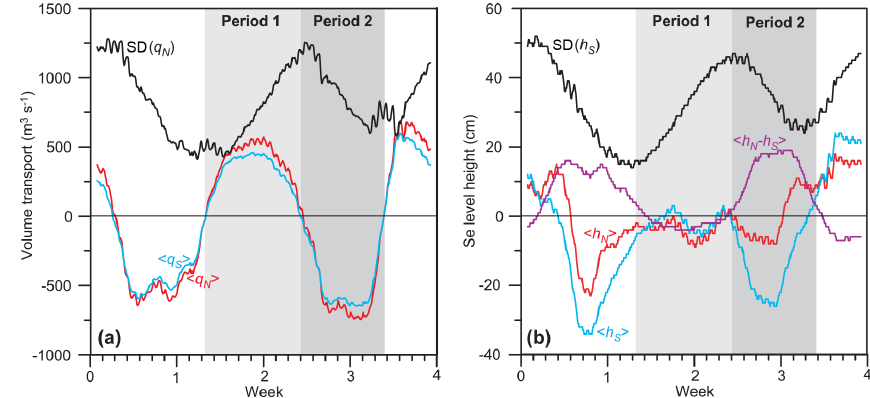
Figure 7. Daily (25h) averages ( <> ) and standard deviations (SD) within each 25h period for (a) volume transports and (b) sea level heights. The standard deviations ought to be dominated by the strength of the tidal amplitudes and should therefore reflect the variation between spring and neap tides. The shaded areas indicate two periods discussed in the text: Period 1 lasting 188h from 21 February at 08:00LT to 1 March at 03:00LT and Period 2 lasting 158h from 1 March at 04:00LT to 7 March at